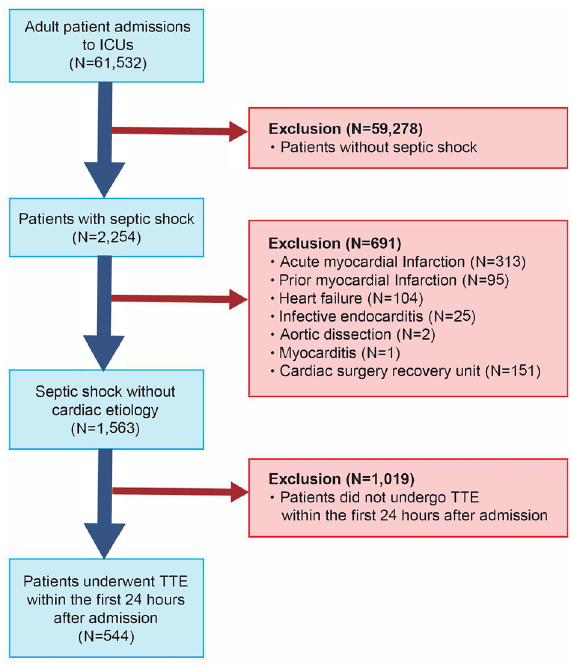
Figure 1. Flow diagram showing initial selection of the cohort and excluded patients. ICU intensive care unit, TTE transthoracic